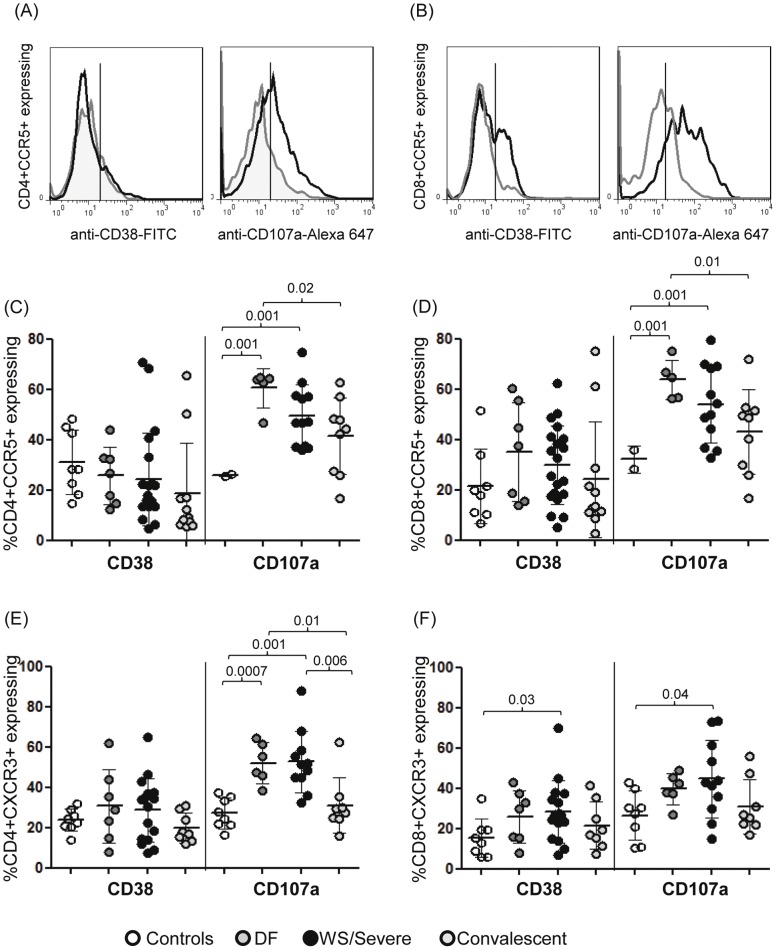
Phenotype of CCR5- or CXCR3 among CD4 and CD8 T cells from DENV-patients.Representative histogram plots comparing (A) the frequency of CD38+ or CD107a+ among CD4+CCR5+ T cells and (B) the frequency of CD38+ or CD107a+ among CD8+CCR5+ T cells between one healthy control (gray line) and one DENV-patient (black line). Vertical bars indicate the positive values based an appropriate matched isotype control antibodies. Percentage of CCR5+CD4+ (C) or CCR5+CD8+ T cells (D) expressing among CD38+ or CD107a+; percentage of CXCR3+CD4+ (E) or CXCR3+CD8+-T cells expressing among CD38+ or CD107a+. Horizontal bars indicate the mean values, standard deviation for each population. The Mann–Whitney U-test was used to analyze differences between control and patient groups. Statistically significant P values for differences between patients and controls are shown above the figures.